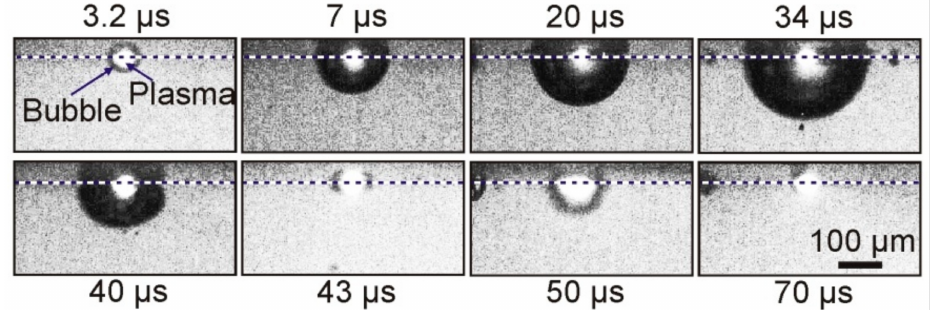
Figure 4. A sequence of frames obtained using time-resolved shadow microscopy during the generation of a vapor–gas bubble in water under the impact of a laser pulse with a duration of τ = 8 ns and an energy of E = 68 µ J on the absorbing Ti layer in Configuration 2 (Figure 1B). Each frame shows the time after exposure to the laser pulse. The dotted line shows the position of the Ti film on the lower surface of the glass